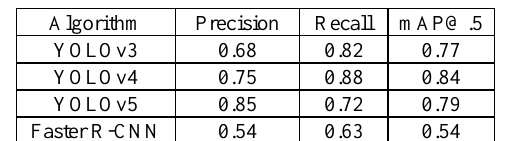
Table 2 . The results of each model. The metrics are normalized between 0 and 1.